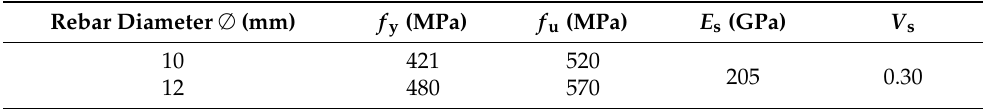
Table 3. Mechanical properties of